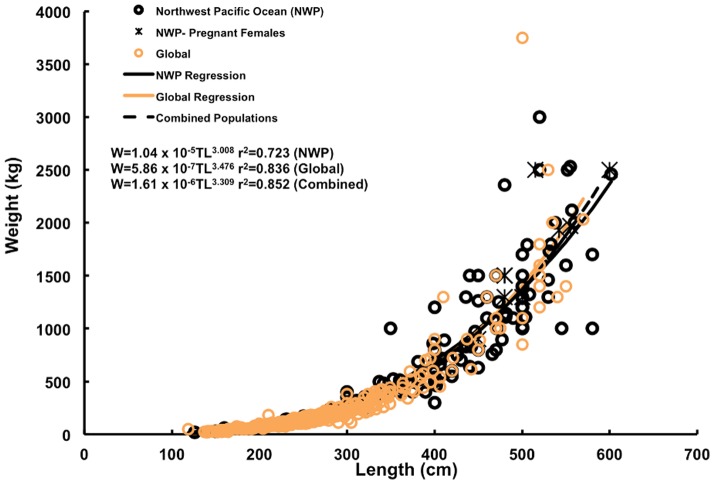
Length-weight regressions for white sharks by region.Regressions were fit to white shark data for the Northwest Pacific (black circles/line), global data recorded by trained scientists (orange circles/line) and all data combined (dashed black line). Pregnant females from the Northwest Pacific (black stars) were not included in the analysis.